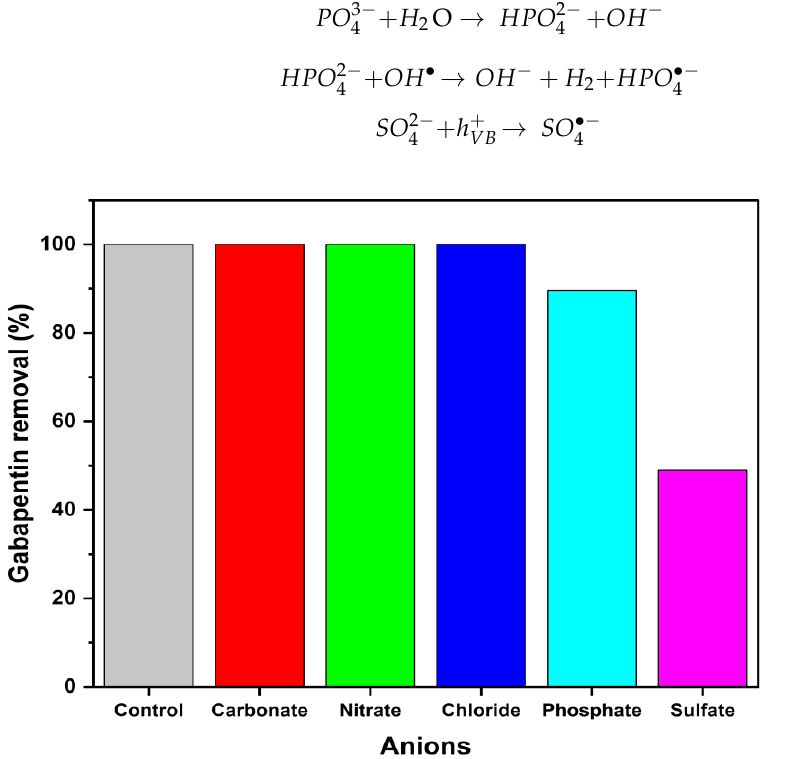
Figure 10. Effect of different water anions on GBP degradation in the Cu-TiO 2 /UVA process (GBP = 10 mg/L, pH = 8, catalyst = 0.4 g/L, anion = 1 mM, reaction time = 20 min).